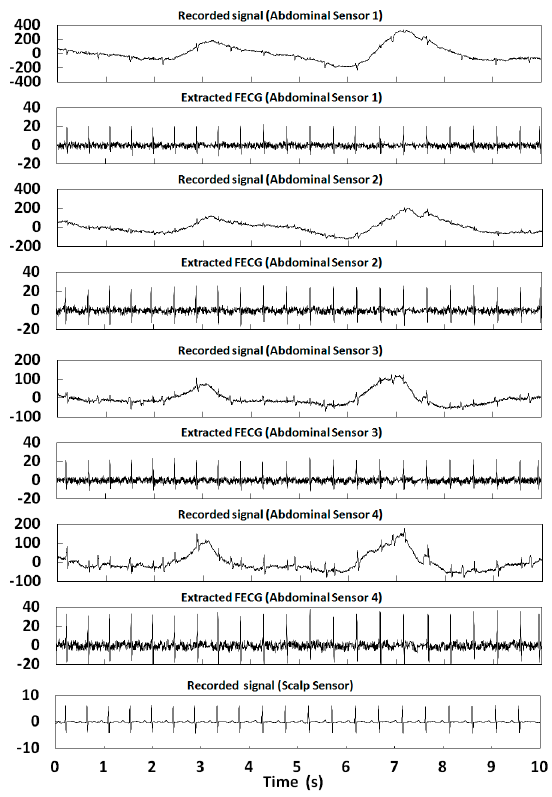
Figure 15. Extraction results for r08 in the ADFECGDB database.